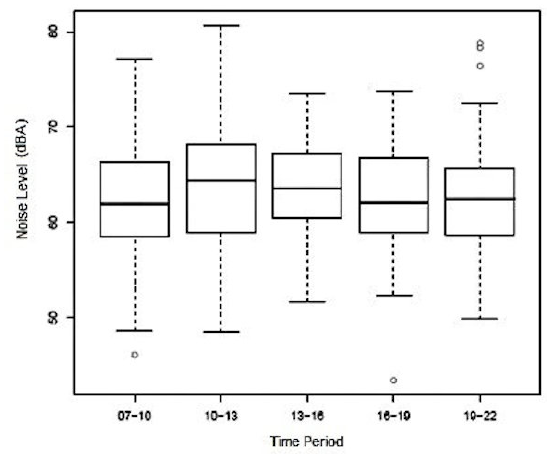
Figure 4. Box diagram of the